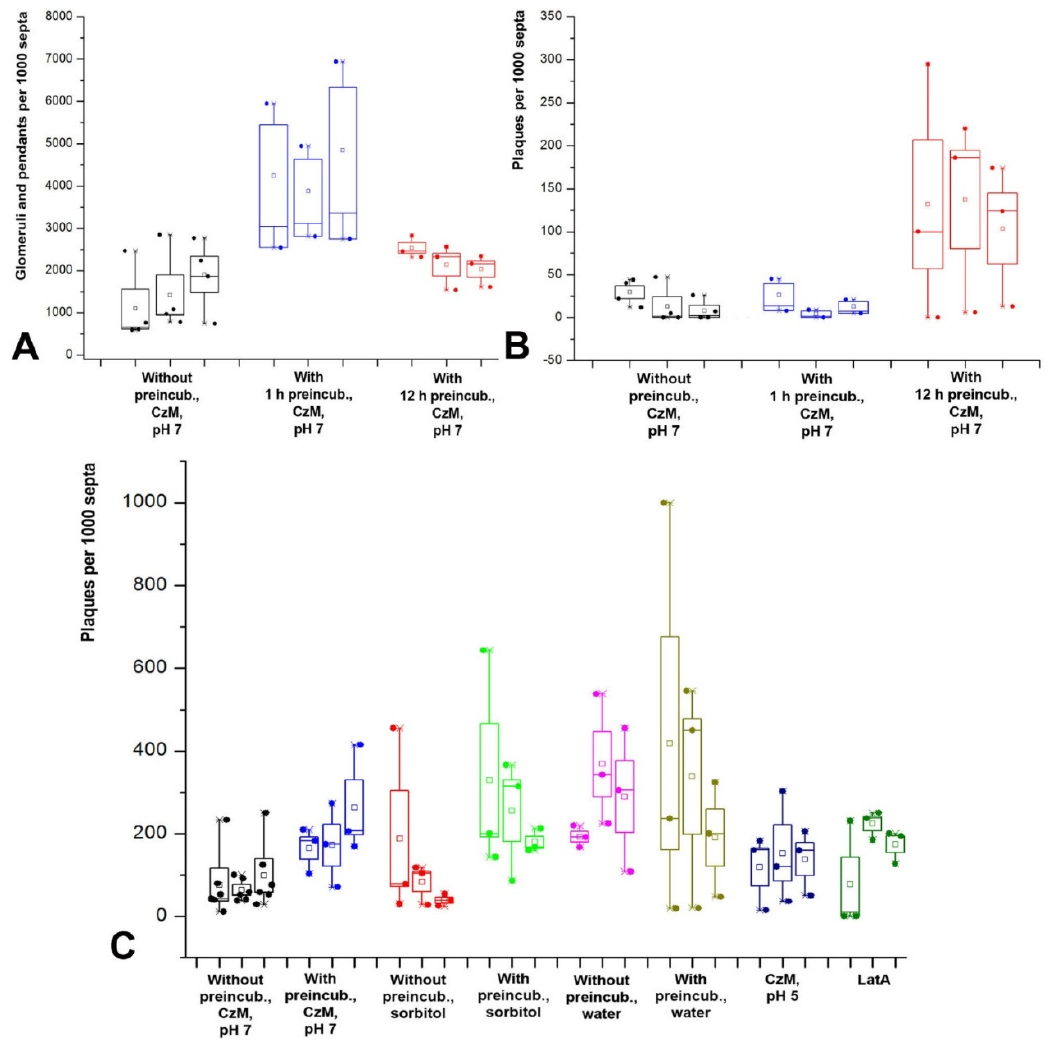
Figure 4. Diagrams showing the quantitative representation of plaques, glomeruli, and pendants in S. hirsutum and O. olearius . ( A , B )—the diagrams reflect the influence of different variants of O. olearius mycelium preincubation on the formation of glomeruli and pendants ( A ) and plaques ( B ). ( C )—formation of plaques in S. hirsutum with different types of sample treatment. Legend: small square—mean; box—50% standard deviation, the whisker–min/max.